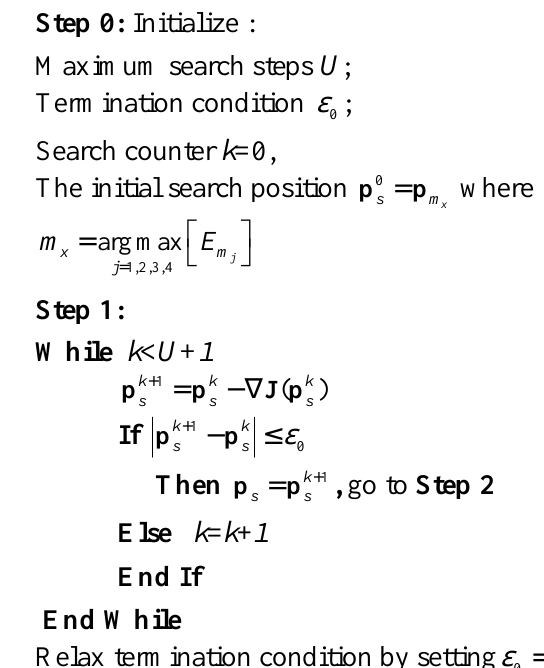
Figure 6. Steepest descent search algorithm with termination condition